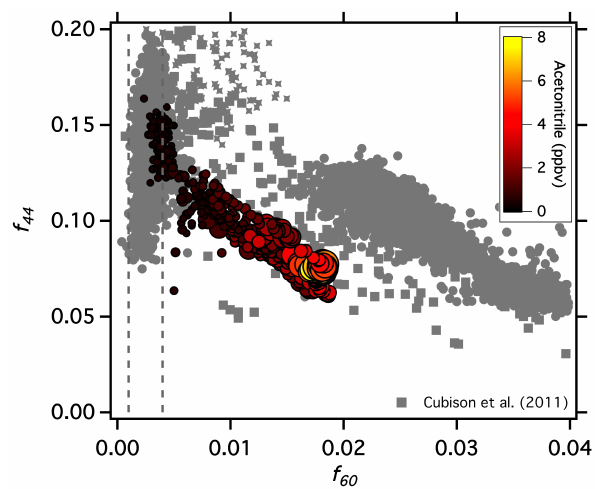
Fig. 1. Relationship between AMS f 44 and f 60 , colored by acetoni- trile and sized by CO concentration. Range of background f 60 lev- els shown as the vertical dashed lines (Cubison et al., 2011). Grey data is all data from Cubison et al. (2011). Acetonitrile determined from interpolation of the discrete GC-MS